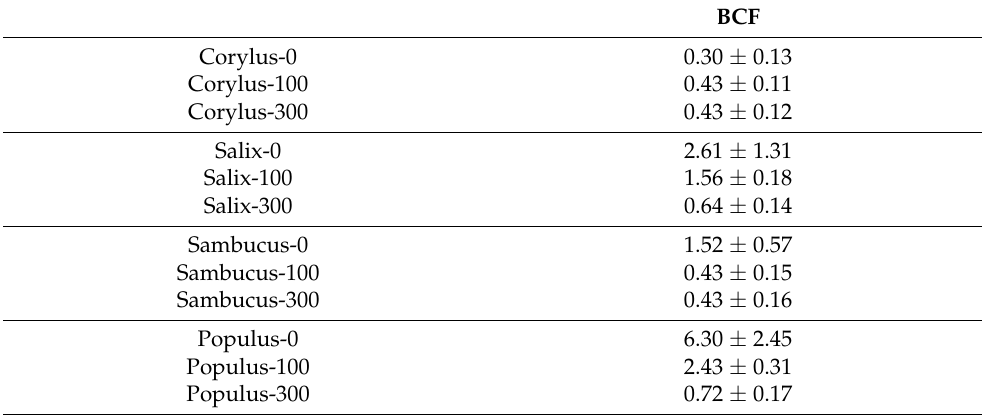
Table 5. Bioconcentration factor (BCF) in Corylus , Salix , Sambucus , and Populus calculated for the four tree species based on the amount of nitrate absorbed from the solutions at 15